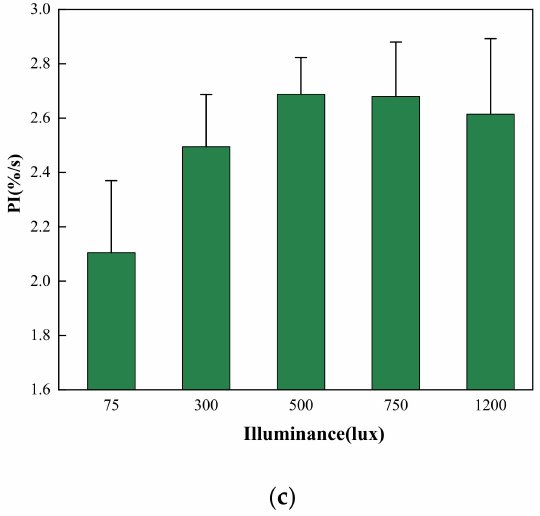
Figure 15. Cognitive task performance at different illuminances: ( a ) RT, ( b ) AC, and ( c ) PI. Table 10. Task evaluation indicator One-way ANOVA results.